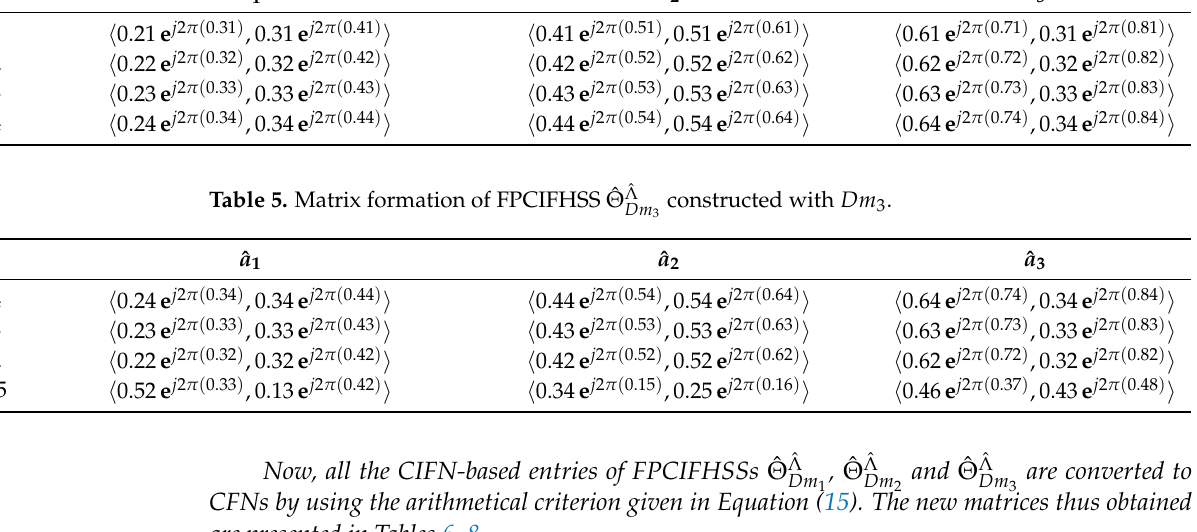
Table 4. Matrix formation of FPCIFHSS ˆ Θ ˆ Λ